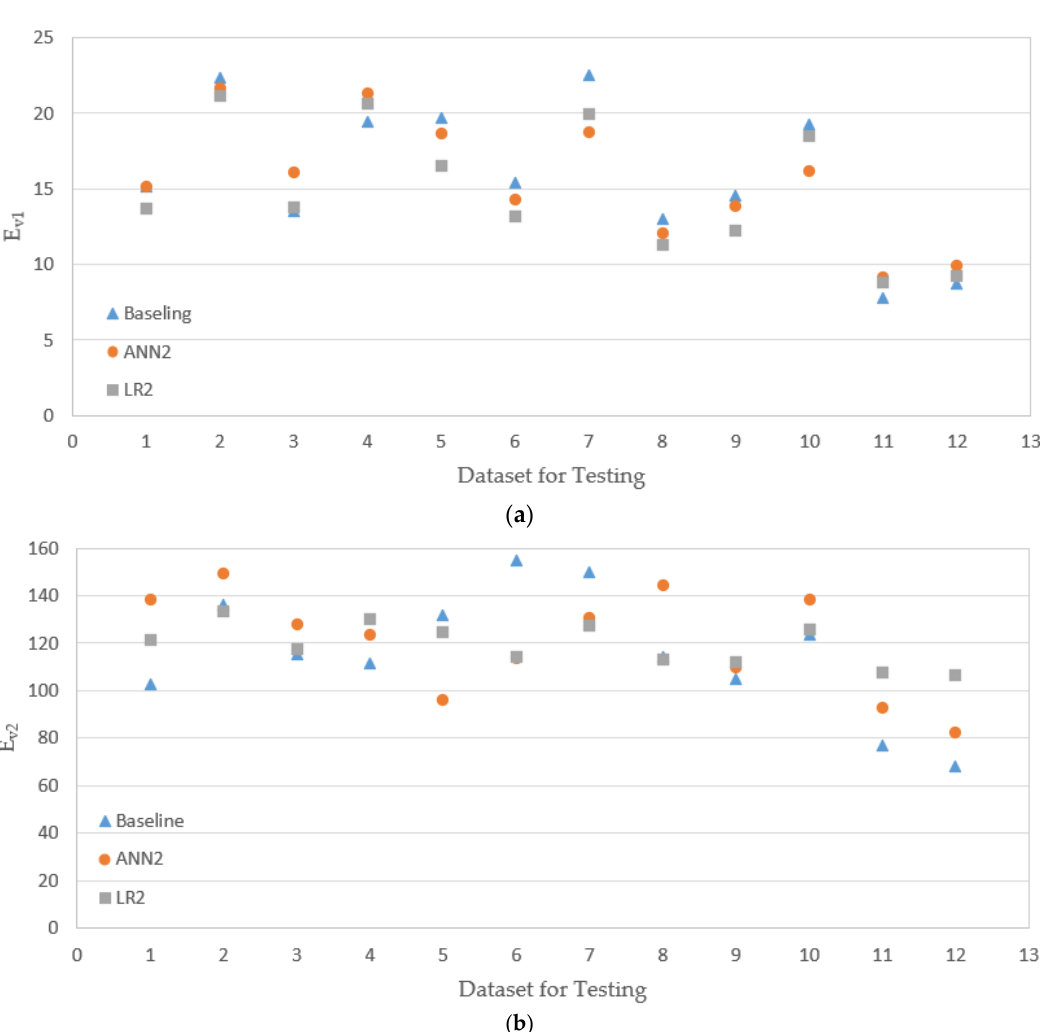
Figure 13. Testing results 1 (results of ANN are based on the model ANN1, and results of LN are based on the model LN1). ( a ) Testing results from E LWD ; ( b ) testing results from E v1 ; ( c ) testing results from E v2 .